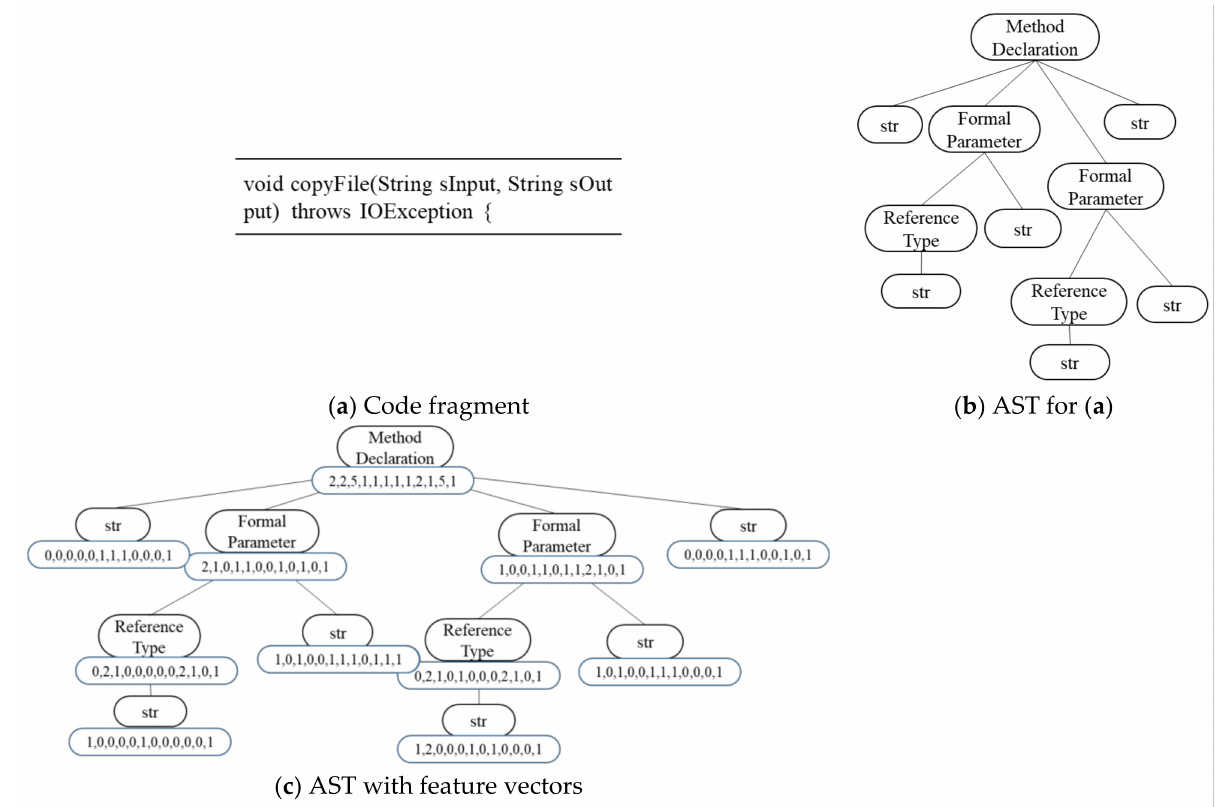
Figure 1. A sample AST and AST with generated feature